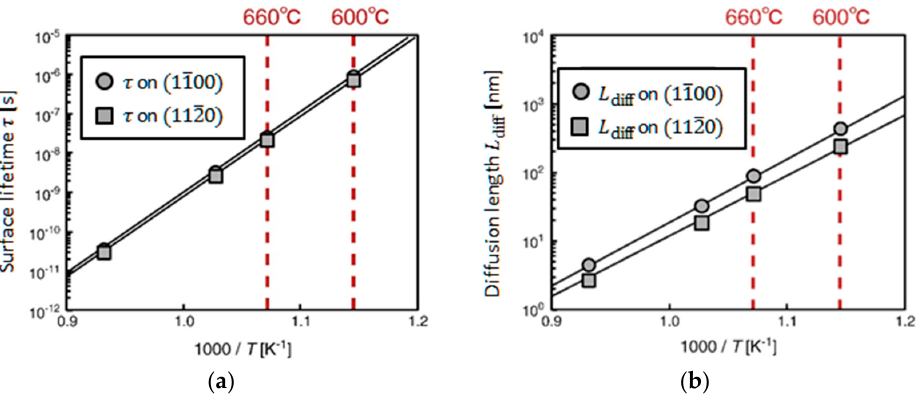
Figure 30. Temperature dependence of ( a ) surface lifetime τ and ( b ) diffusion length L diff for an In adatom on ( 1100 ) and ( 1120 ) surfaces. In pressure is fixed at 3.3 × 10 − 3 Torr, which corresponds to the experimental growth conditions [90,91]. Reprinted with permission from [99]. Copyright (2013) by Elsevier.